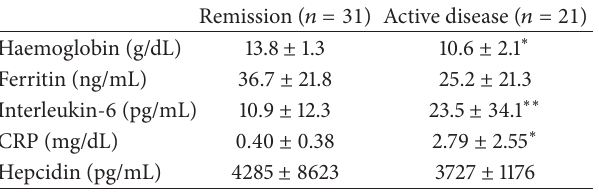
Table 4: Comparison of anaemia parameters, hepcidin levels, and inflammatory markers between ulcerative colitis patients with different disease activities.